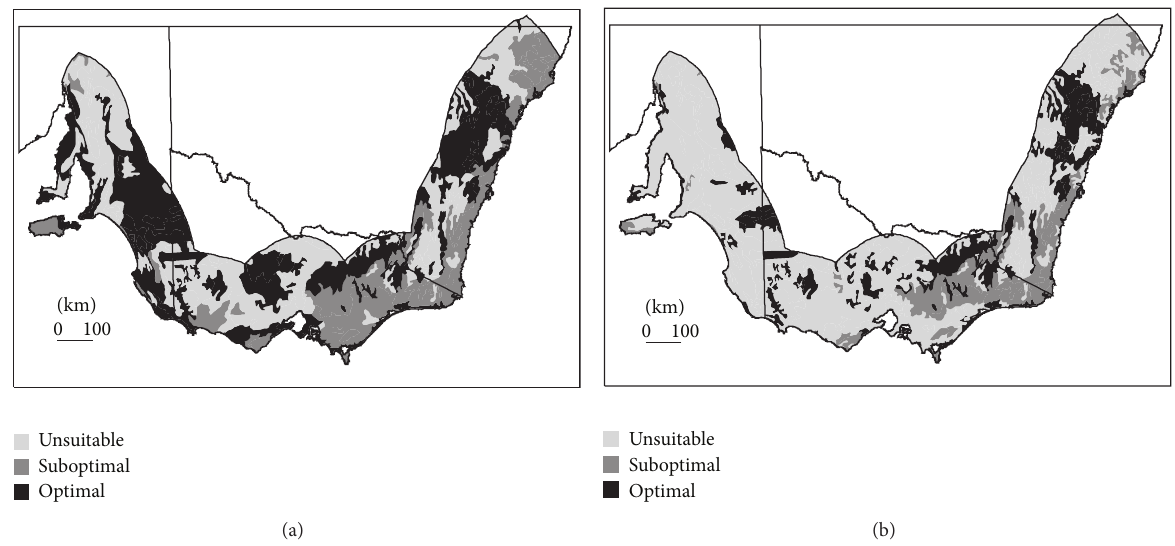
Figure 7: Suitability of vegetation for Isoodon obesulus obesulus (a) c. 1788 and (b) c.